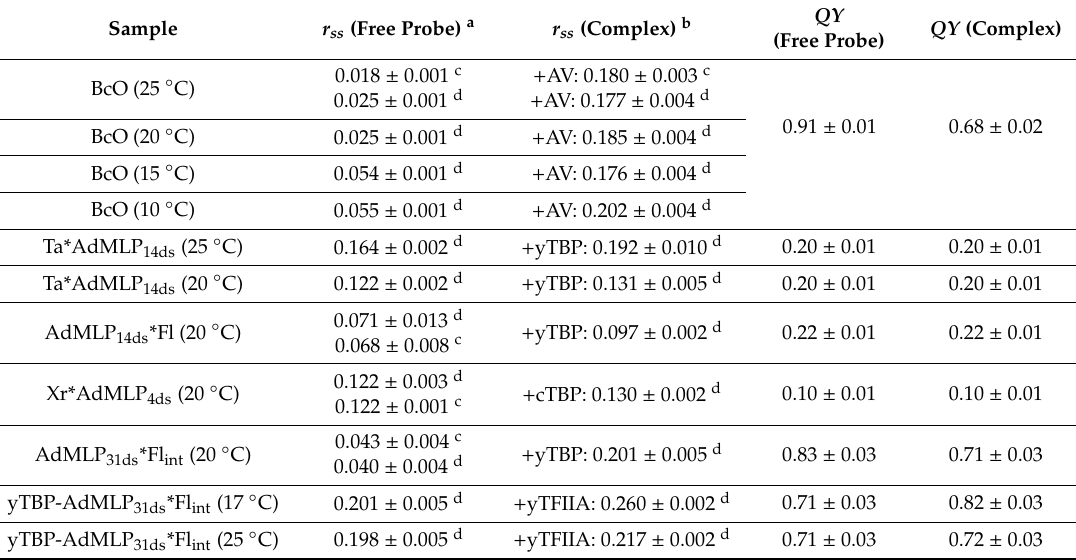
Table 2. Steady-state anisotropy ( r ss ) and quantum yield ( QY ) for unbound probes and